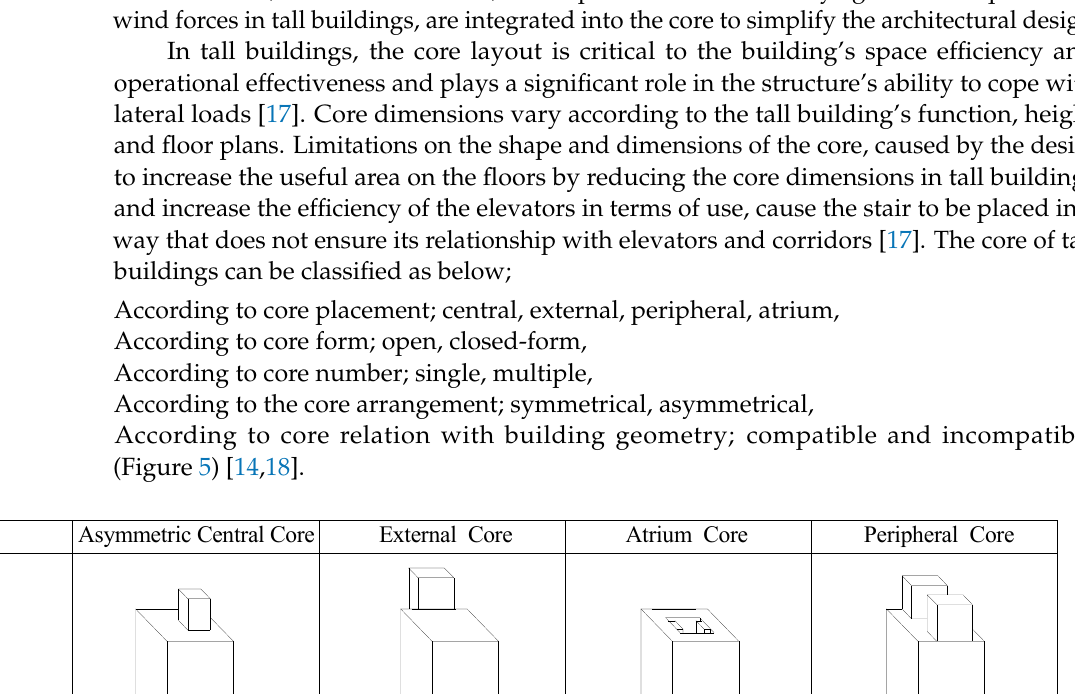
100 Figure 6. Analysis of selected tall buildings by the core planning. Central cores are more widely used than other core types due to opening up the ex- terior spaces for light and scenery, enabling easier access to fire-escape stairs, resisting 57.0% 15.2%26.5%1.3% Core Planning Central Asymmetrical Central Peripheral Core Atrium